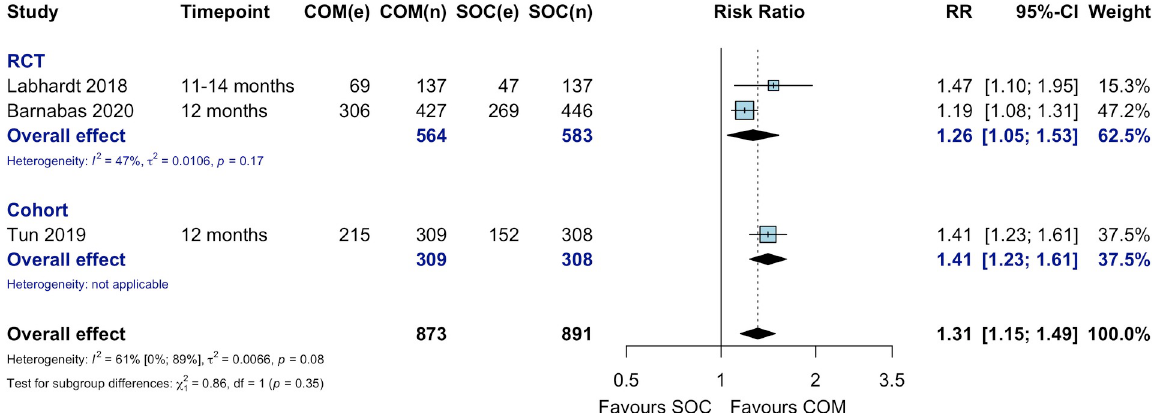
Fig 6. Viral suppression among HIV-positive individuals at 12 months: Community ART initiation versus facility-based care. COM, community ART initiation; e, number of events; n, number of participants; RCT, randomized controlled trial; RR, risk ratio; SOC, standard of care.